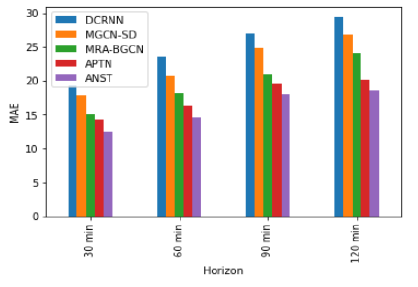
Figure 11. MAE during different